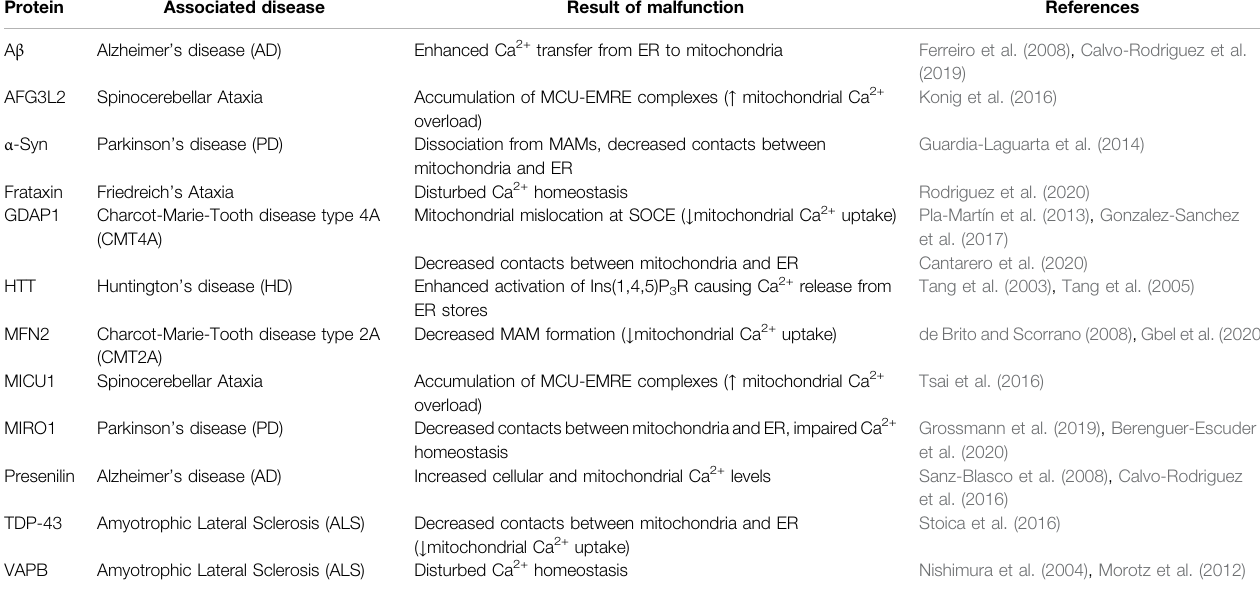
TABLE 3 | Proteins related to disturbed mitochondrial Ca 2+